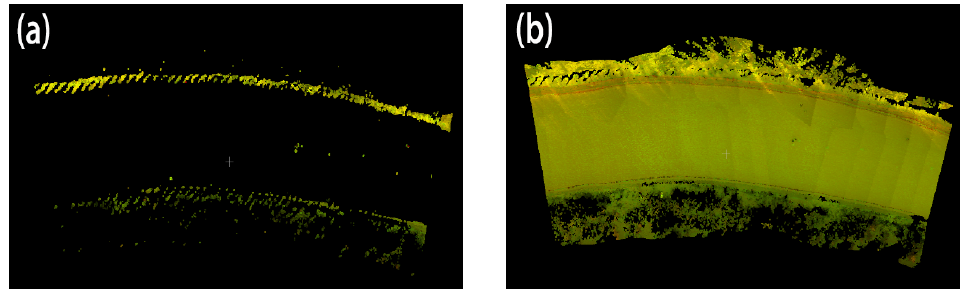
Figure 23. The segmentation results of the datasets of Figure 13b with CSF : ( a ) is the removed points; ( b ) is the remaining